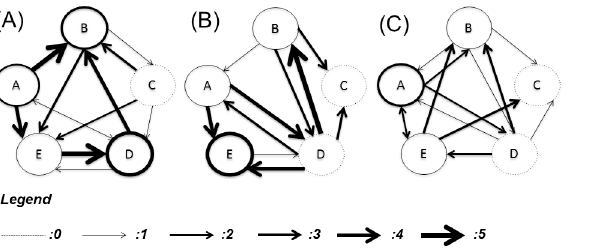
Fig 10. Interconnected networks of clusters. Networks mapped to cell mitosis (A), cell apoptosis(B), and ECM synthesis (C). For illustration purposes the level of interconnectedness betweennetworks was dividedin a range from 0 (dashedline for the cluster self-enhancement and no line for different clusters interconnectednessrepresenting no impact) to 5 (thick solid line representing the maximum impact).